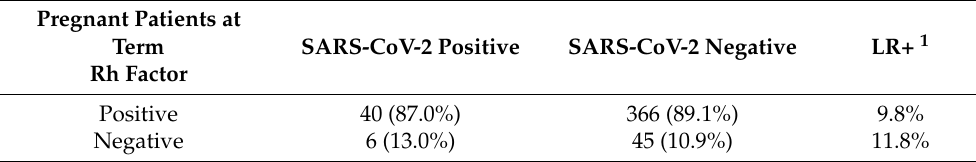
Table 3. Number and percentage of Rh type in the SARS-CoV-2 positive and negative pregnant patients at term.